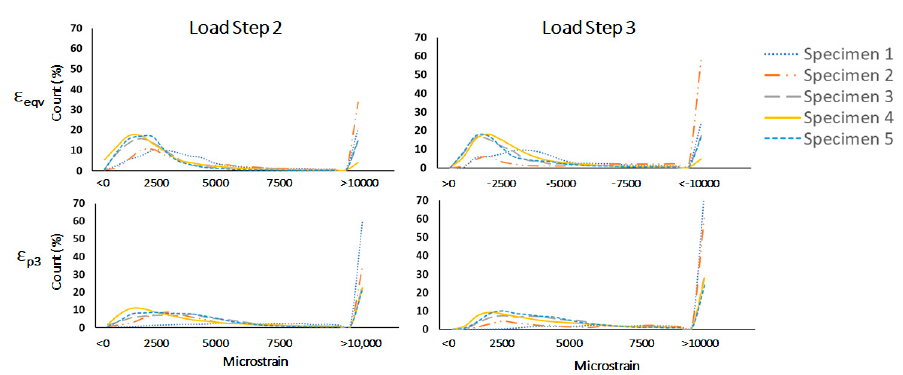
Figure 4. Frequency distributions of strain values output by the DVC for Von Mises equivalent strain ( ε eqv) ( TOP ) and principle compressive strain ( ε p3) ( BOTTOM ) at LS2 ( LEFT ) and LS3 ( RIGHT ). At LS3, there is a distinct increase in the volume of tissue exhibiting ε p3 > 10,000 µε , with a concurrent reduction in tissue volumes exhibiting low strain values, which was consistent across all specimens. Table 3. Spearman’s rank correlation coefficient for exploring linear associations between strain outputs and morphometric properties ( n = 5).